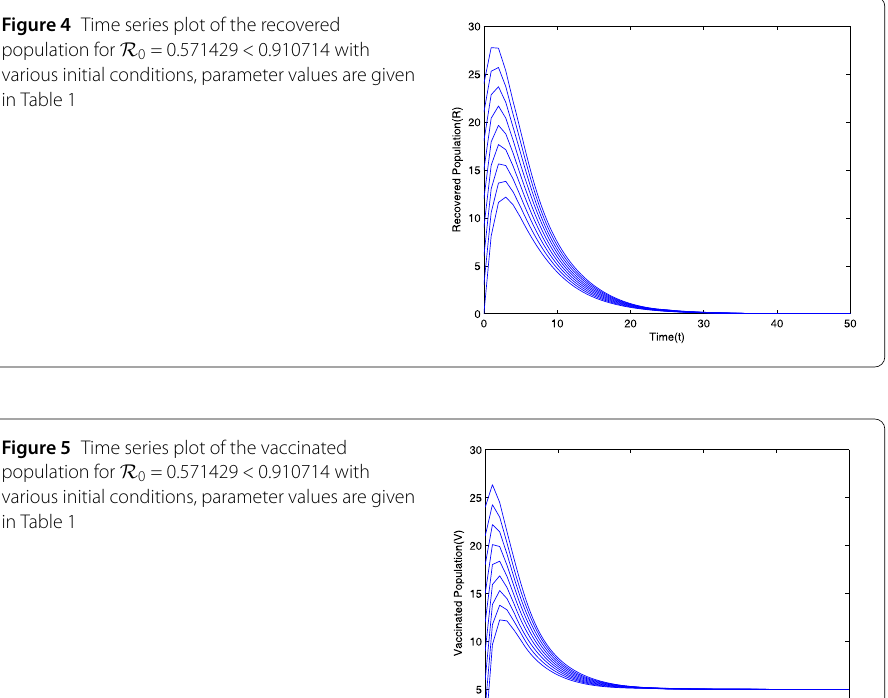
Figure 4 Time series plot of the recovered population for R 0 = 0.571429 < 0.910714 with various initial conditions, parameter values are given in Table 1